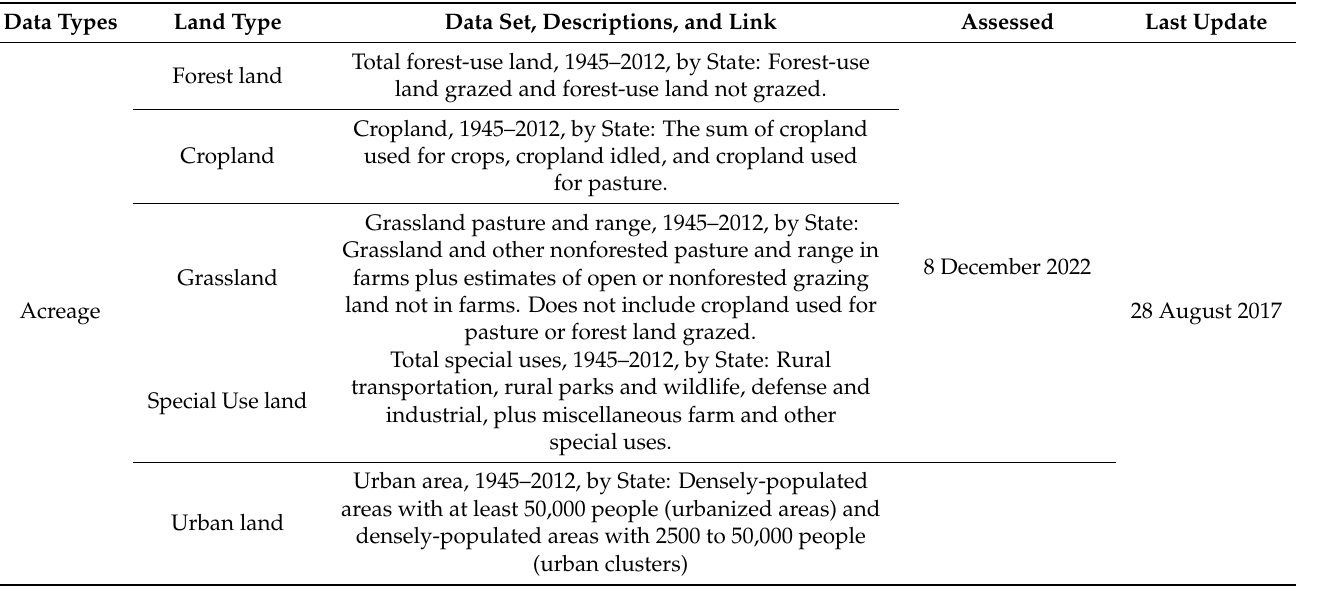
Table 2. The principal data and sources for land type